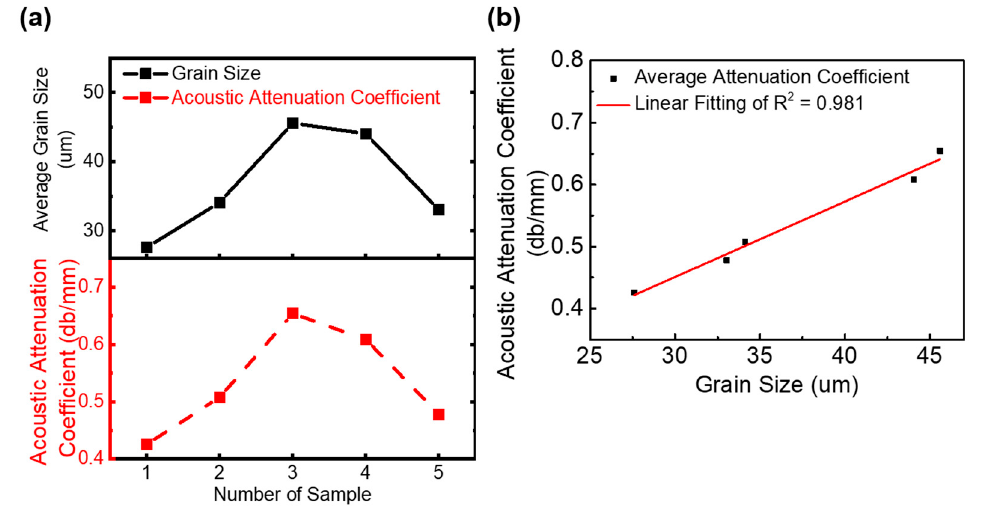
Figure 5. Comparison of characterization of grain size in Samples 1–5 between LOUD and EBSD. ( a ) The average grain size of Samples 1–5 was measured using EBSD (solid black line), and the acoustic attenuation coefficient of Samples 1–5 was detected using LOUD (dotted red line). ( b ) Linear fitting for grain size dependent on acoustic attenuation coefficient.